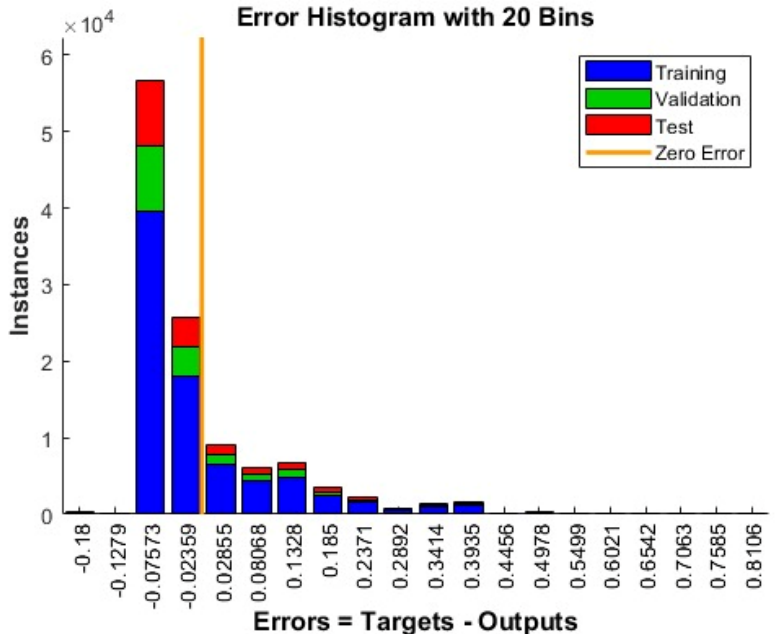
Figure 6. Regression scatter-plot graphs.